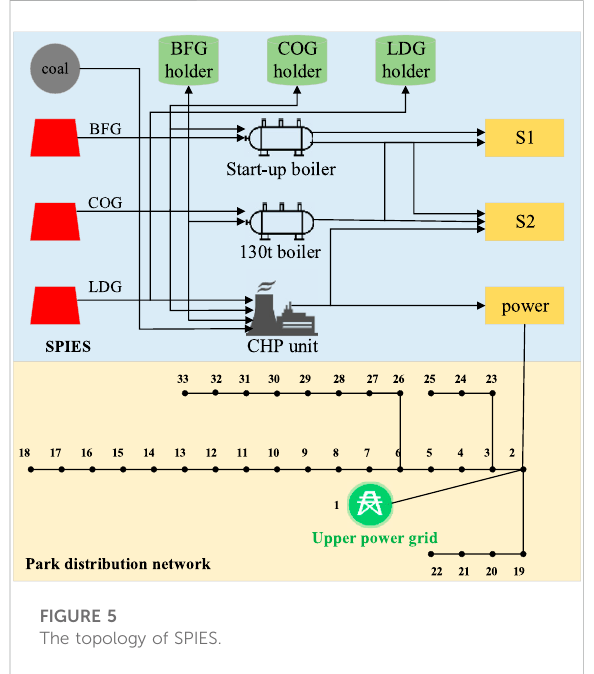
FIGURE 5 The topology of SPIES.